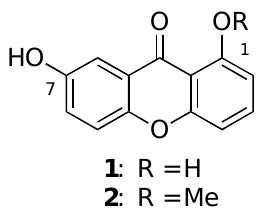
Figure 1. Xanthones from Hypericum